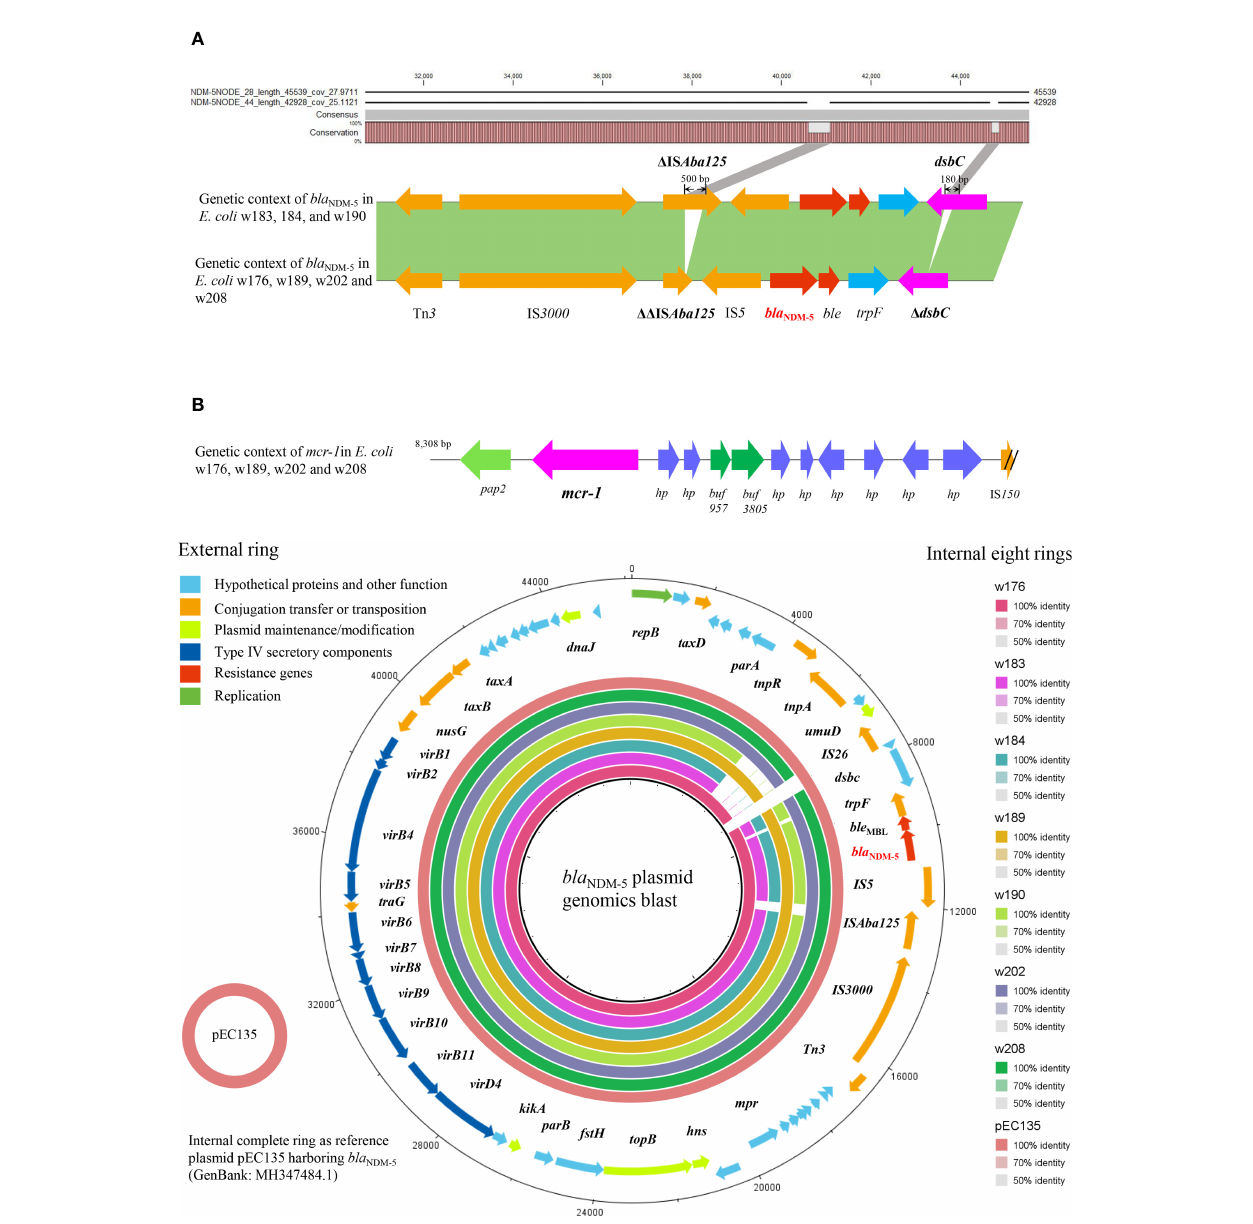
FIGURE 6 | The analysis of bla NDM and mcr-1 genetic environments. Genetic context of bla NDM-5 (red) and the analysis of deletion fragments in D IS Aba125 and dsbC by Blast are shown (A) . Genetic organization of mcr-1 (purple) is shown in (B)